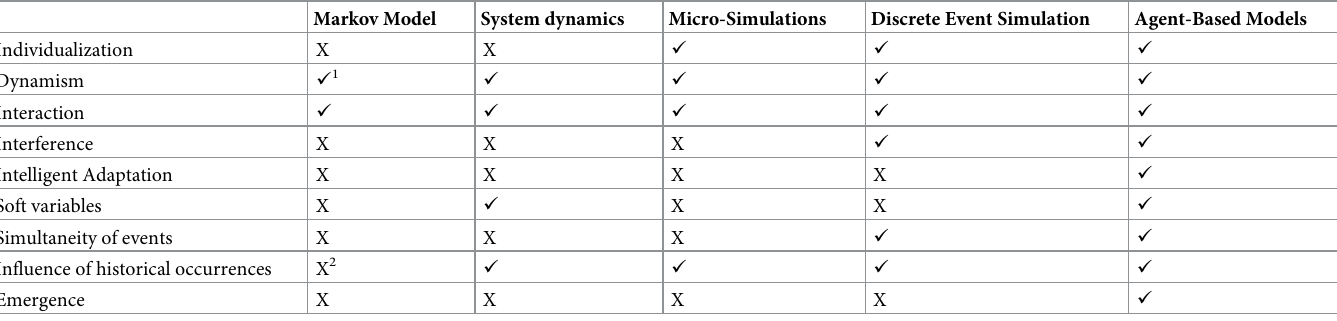
Table 3. Complexity aspects enabled per simulation modeling